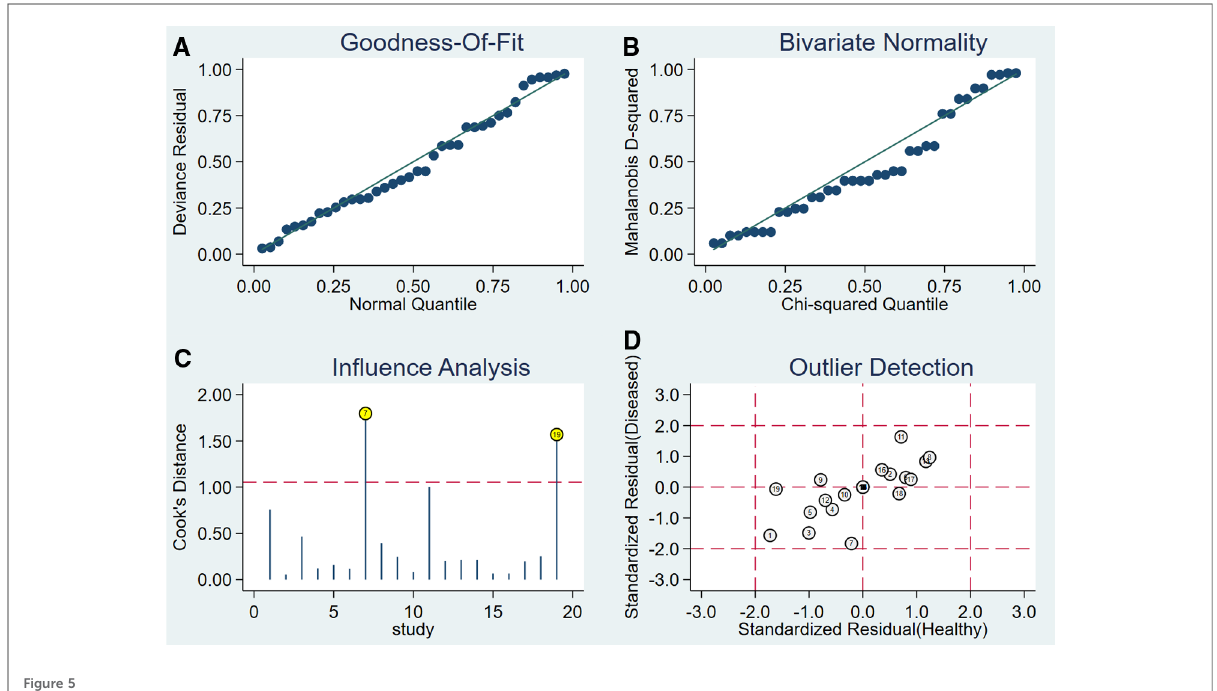
Figure 5 The sensitivity analysis of MRI.